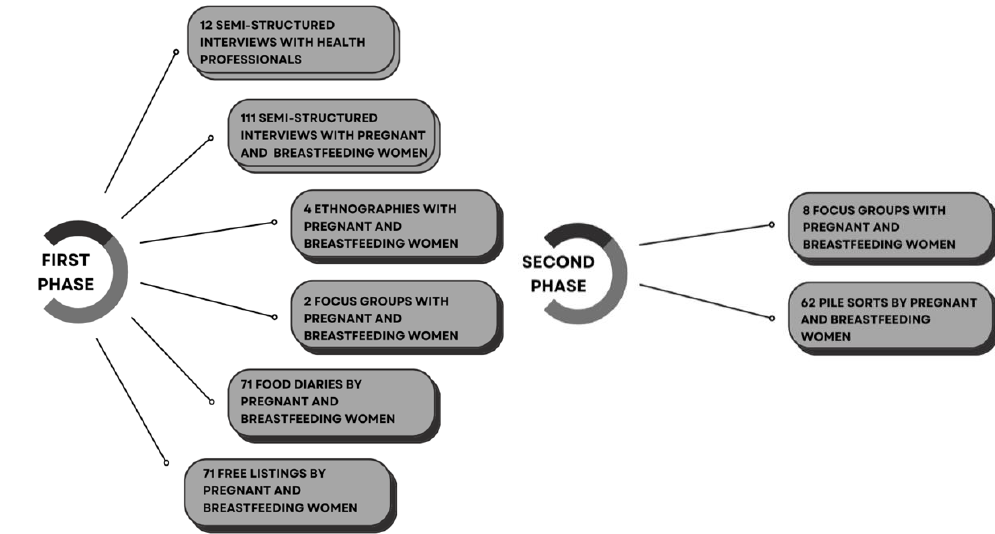
Figure 1. First and second phases. Data collection instruments.